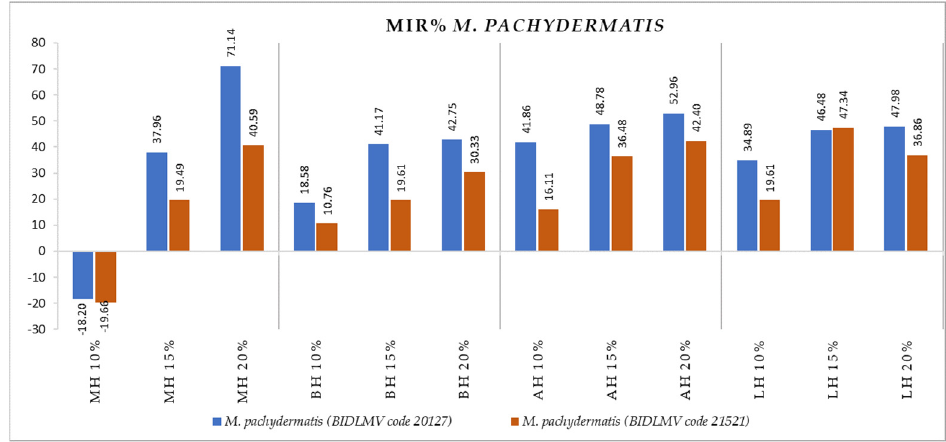
Figure 12. Antimicrobial activity (expressed as MIR%) of honey samples tested on P. aeruginosa isolates. Table 1. The OD reading of honey samples tested on the ATTC strains.